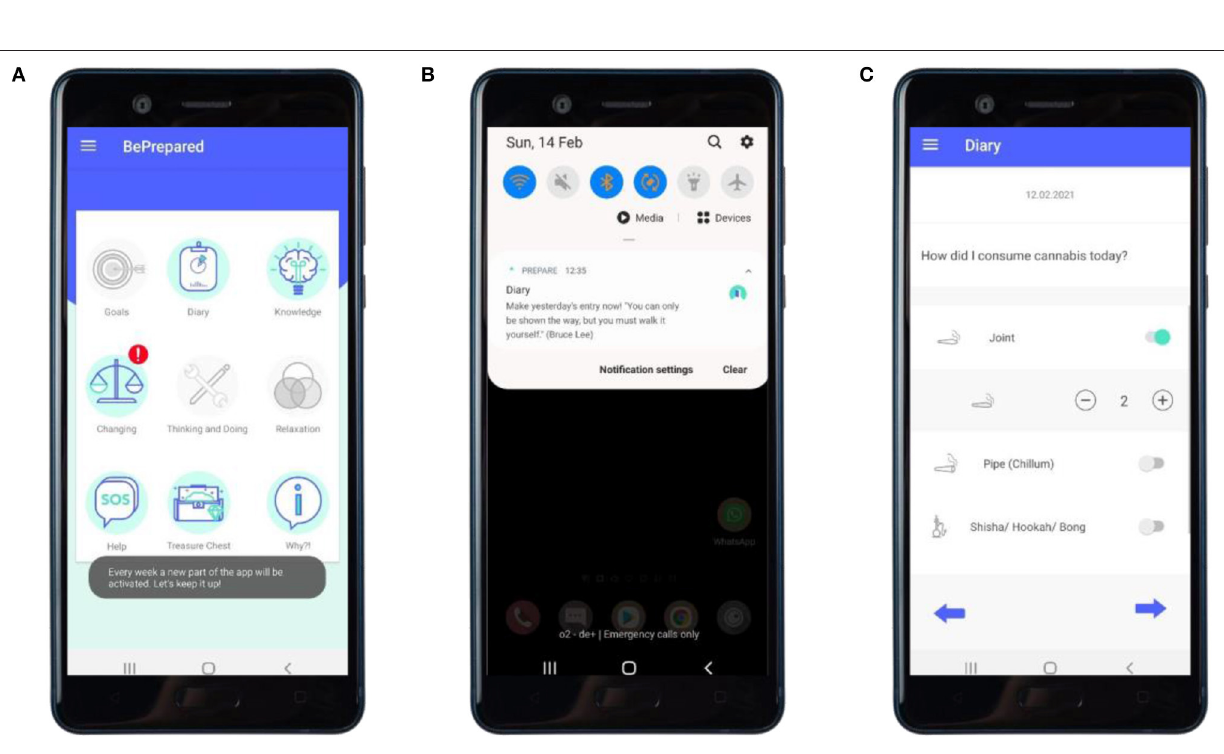
Frontiers in Public Health |